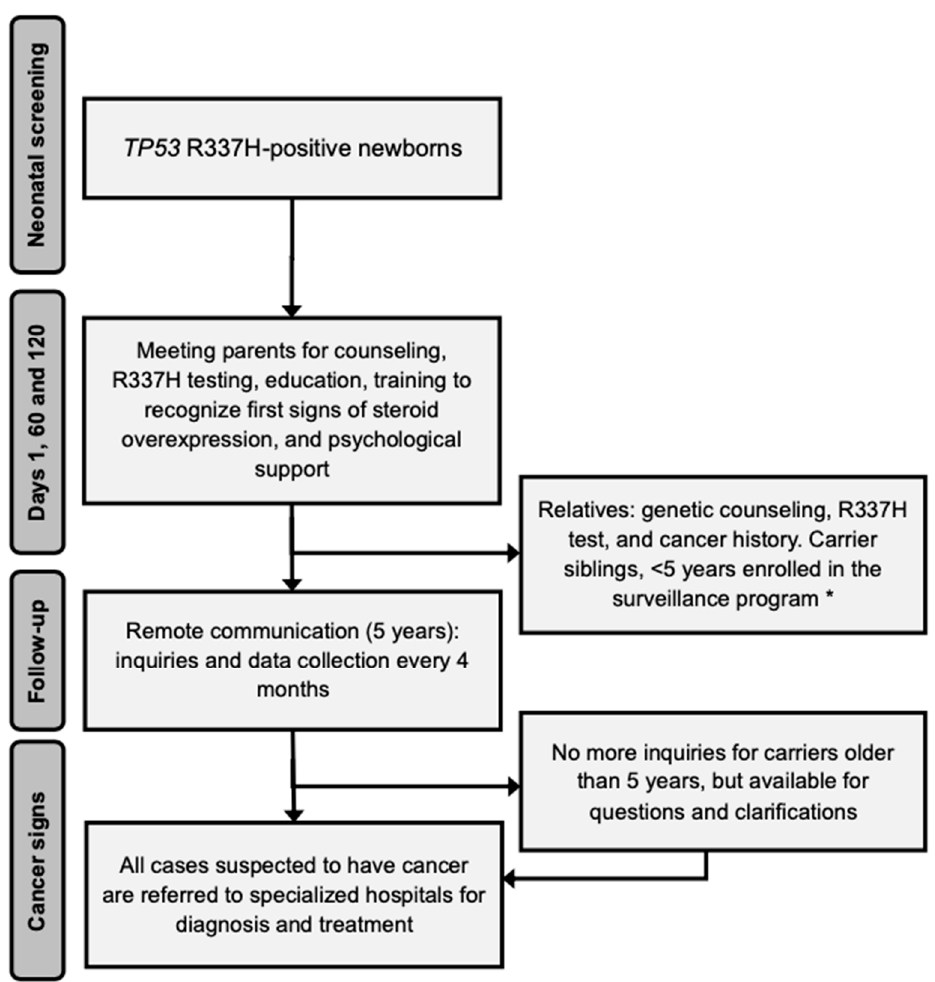
Figure 1. Follow-up flowchart for R337H screening and ACT treatment. * Provided at the study center or at another center closest to the participant home address.